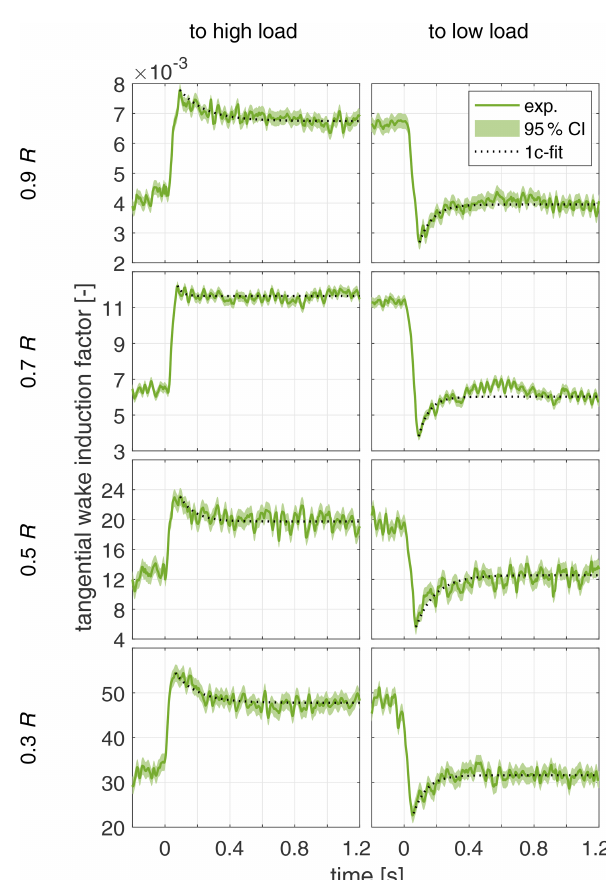
Figure 13. Tangential wake induction factor over time for pitch step to high load and low load for the four radii 0.3, 0.5, 0.7 and 0.9 R and the fitted exponential decay model with 1 time constant